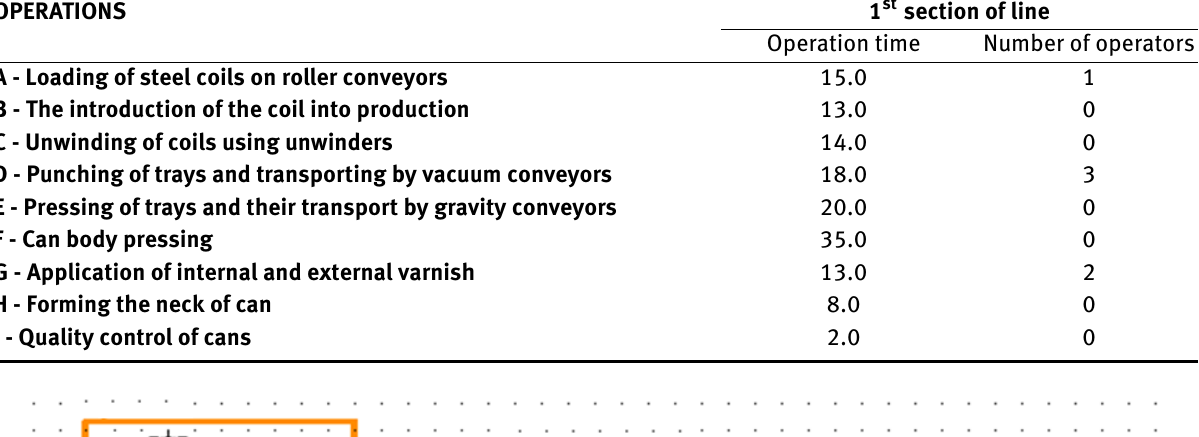
Table 2: Timelines of technological operations in the Line Sections 1.